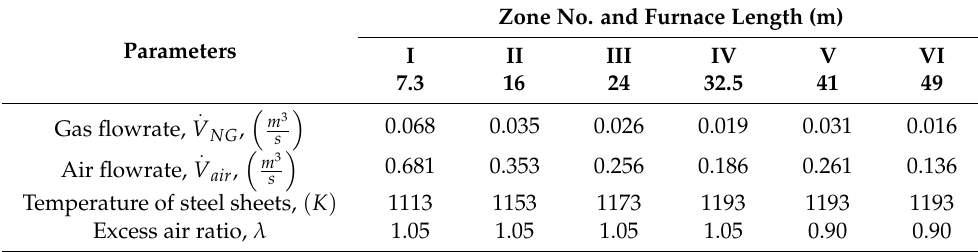
Table 1. Technical parameters of tunnel furnace.